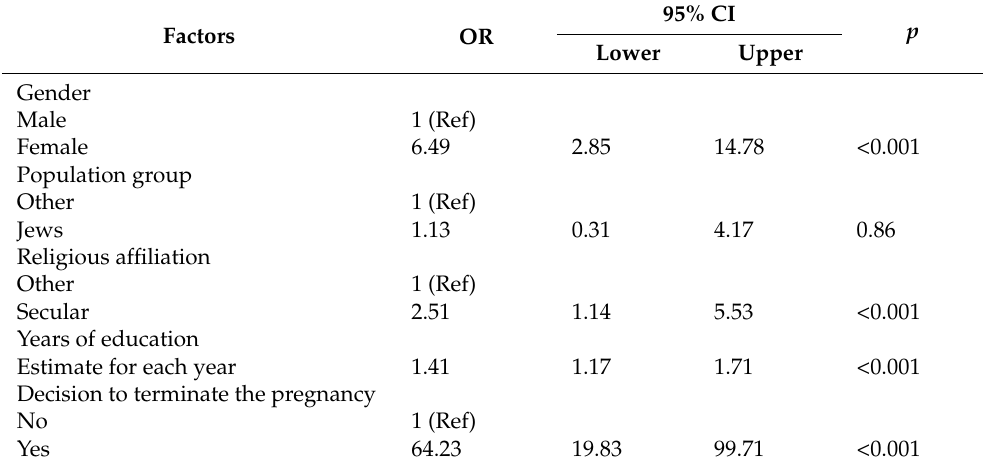
Table 2. Logistic regression model of factors that influence vigilance in the decision-making